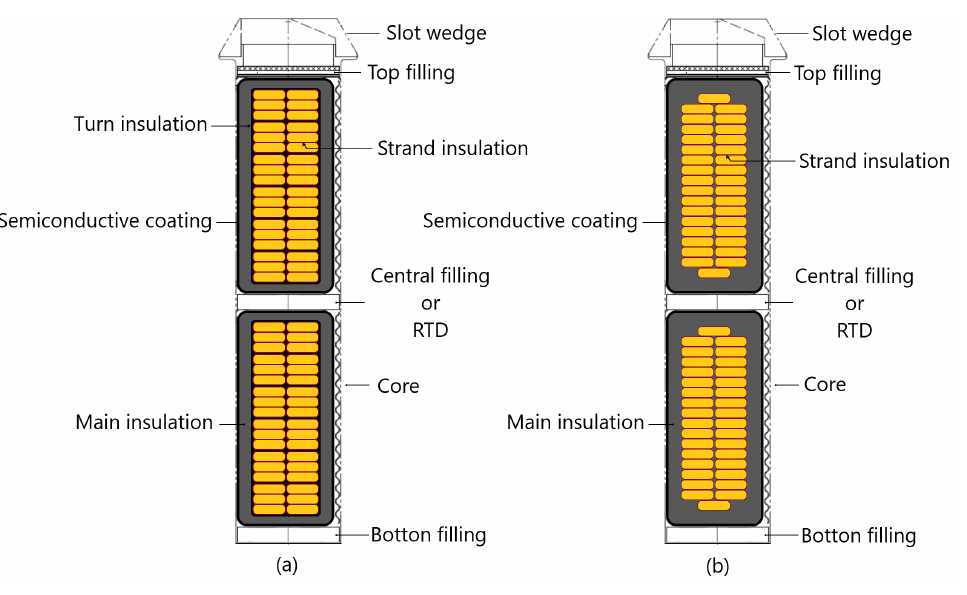
Figure 1. Cross-section of a slot ( a ) multi-turn coil and ( b ) Roebel